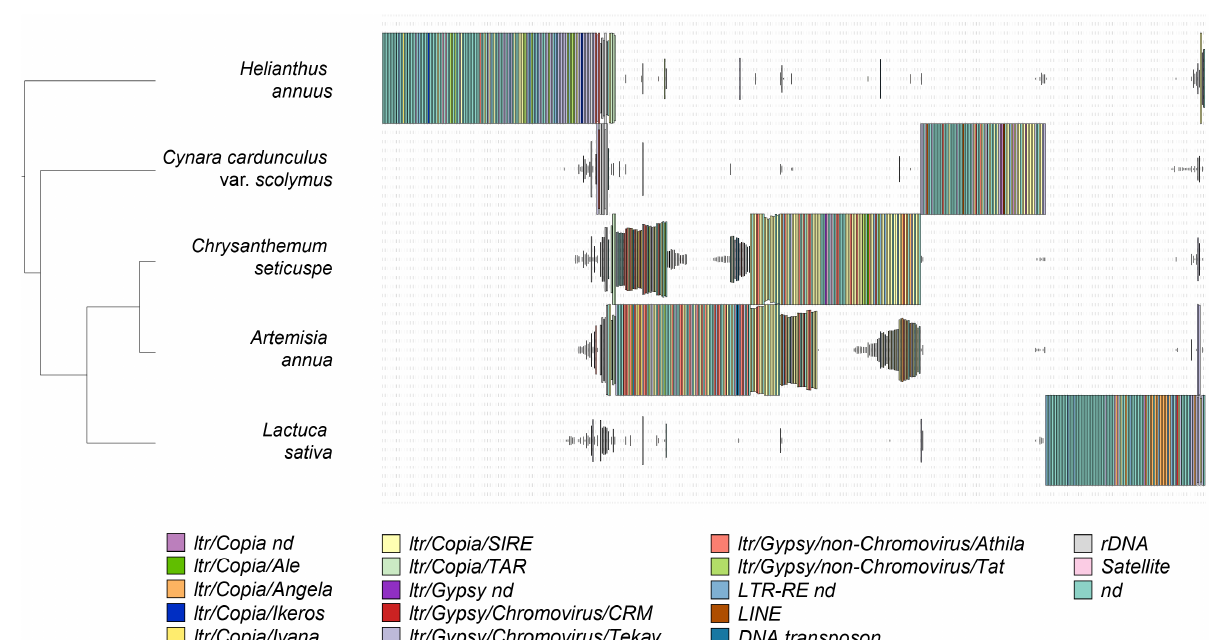
Figure 3. Comparison of hybrid clustering results among the five Asteraceae species. The bars represent the genome proportion of each cluster for each species; a legend is reported to indicate the repeat class, superfamily, or lineage. On the left, groups of clusters are labelled as assessed by hierarchical clustering of the results.